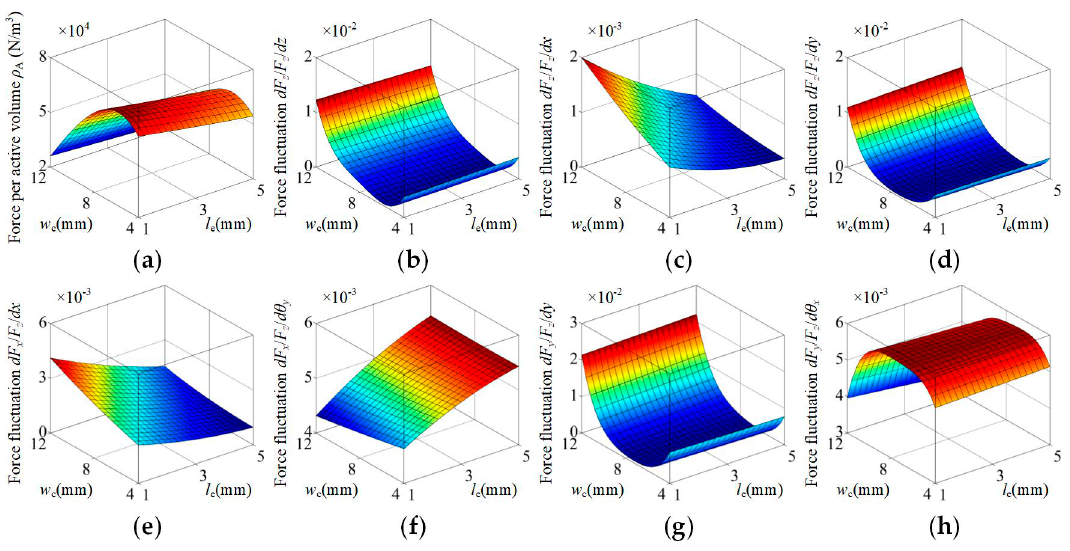
Figure 14. Force density and uniformity of the HMF-VCA varied with structural parameters w s and t e . ( a ) Force density ρ A . ( b ) Variation of F z caused by z . ( c ) Variation of F z caused by x . ( d ) Variation of F z caused by y . ( e ) Variation of F x caused by x . ( f ) Variation of F x caused by θ y . ( g ) Variation of F y caused by y . ( h ) Variation of F y caused by θ x .